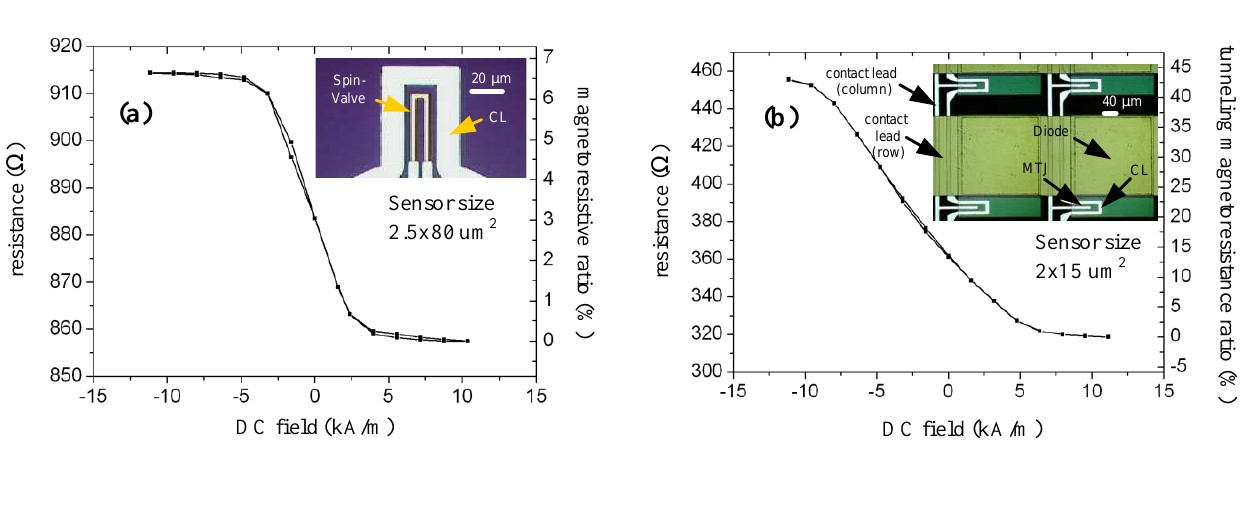
Figure 2. Microphotography and transfer curve of MRsensors of two biochip sensing sites: (a) spin-valve in a lineararray; and (b) magnetic tunnel junction in a